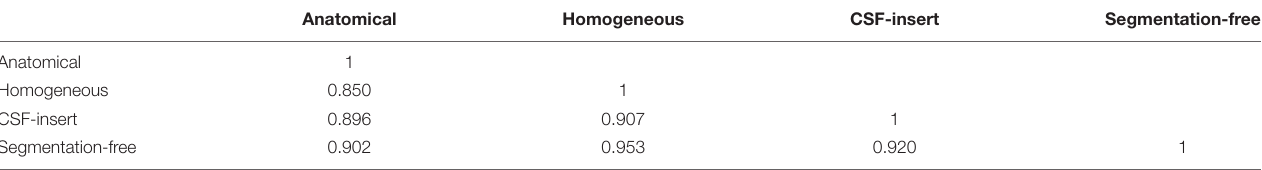
TABLE 3 | Averaged correlation coefficient of potentials on the electrodes between each model for 500 selected test sources. Anatomical Homogeneous CSF-insert